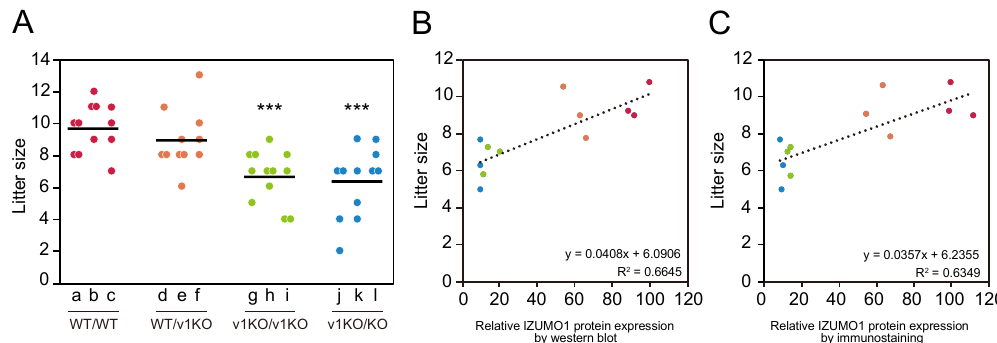
Figure 3. Comparison between litter size and IZUMO1 protein levels. ( A ) Litter size of mice mated with B6D2F1 female mice. Each lane represents an individual score from the four mouse lines. Each alphabetical letter corresponds to the same male individuals as in Figure 1A. The average litter size of each mouse line (total number of pups/total number of births) is indicated by the black bar. Significant differences: *** p <0.001 (Student’s t -test) compared to WT/WT. Correlation of litter size and IZUMO1 expression levels determined with western blot ( B ) and immunostaining ( C ). The color scheme is the same as that in Figure